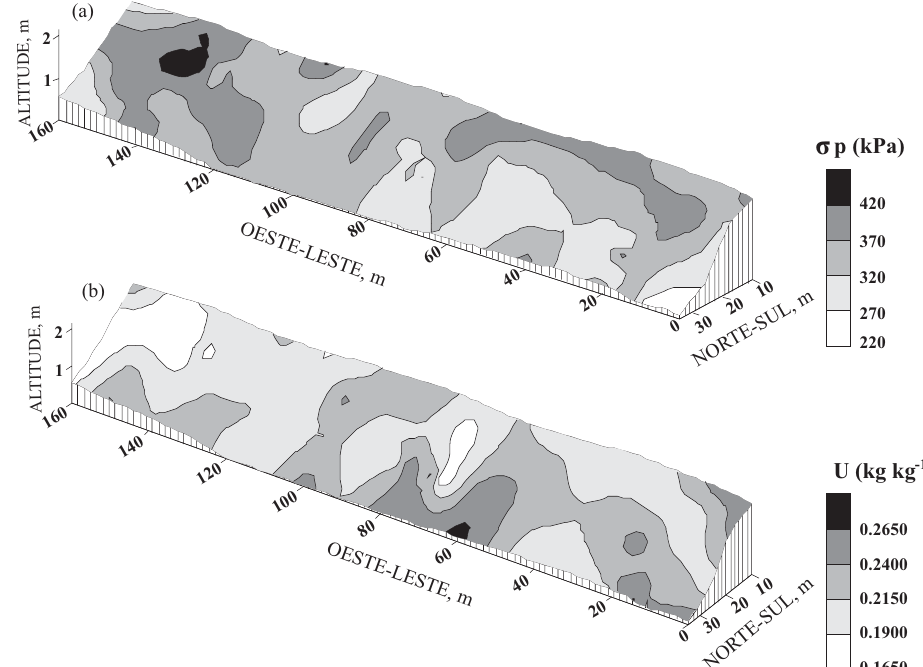
Figura 6. Mapa de isolinhas da pressão de preconsolidação (a) e umidade do solo (b), representado conjuntamente com o relevo da